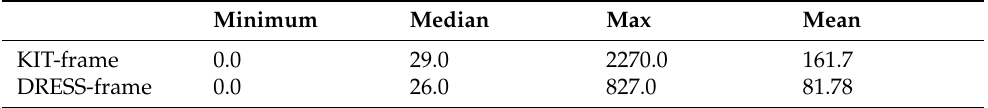
Table 2. Distribution of CELEX wordform frequencies (counts per 17.9 million) for KIT-frame and DRESS-frame